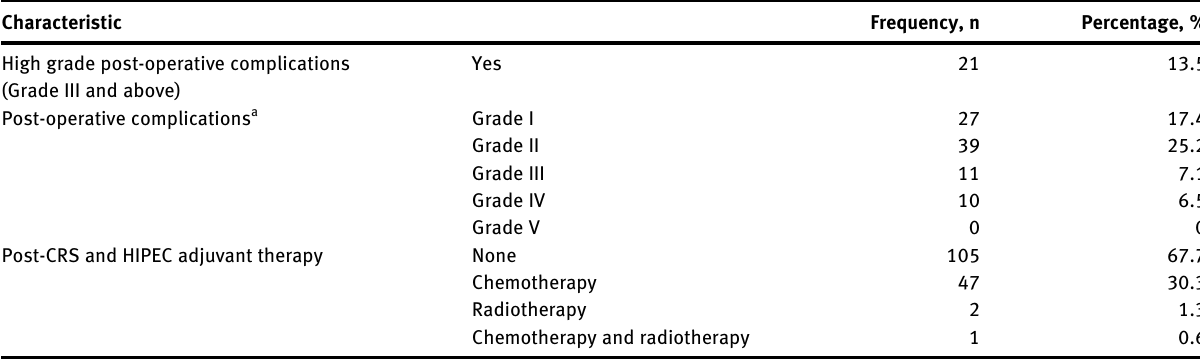
(Table 2B). The differences observed in peritonectomy duration and presence of stoma were no longer signi fi cant at post-operative 6 months.